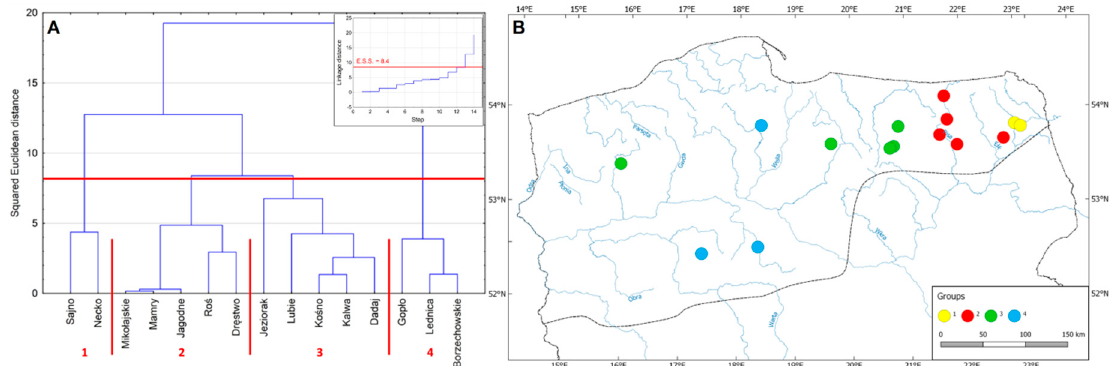
Figure 4. Dendrogram of grouping lakes by values of correlation coefficients of monthly NAO indices with monthly water levels and the plot of the linkage distance ( A ); Spatial distribution of lakes in the performed grouping ( B ).